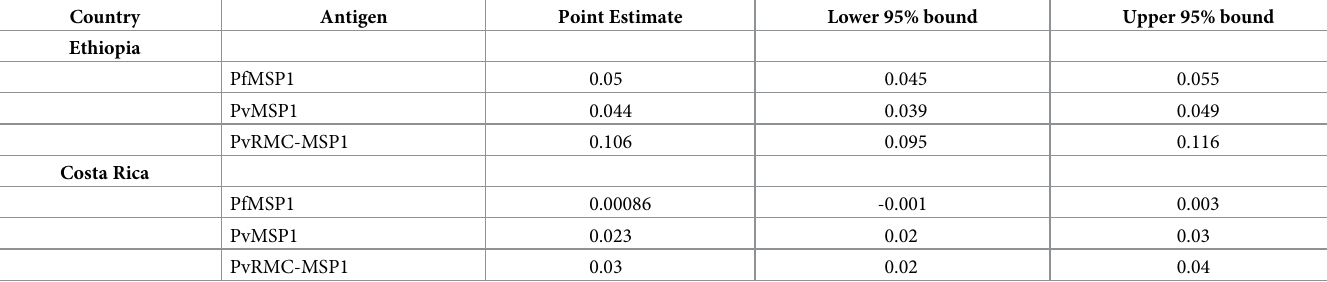
Table 2. Serological conversion rate for plasmodium antigens in the Ethiopian and Costa Rican study populations.